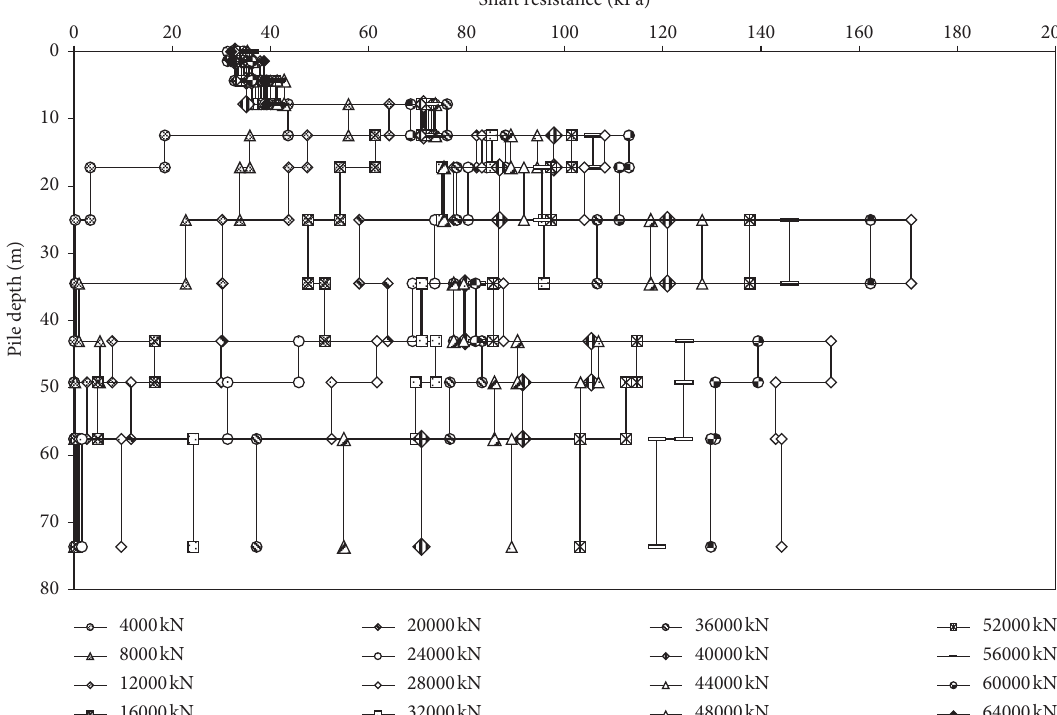
Figure 20: Shaft resistance distribution along the pile for